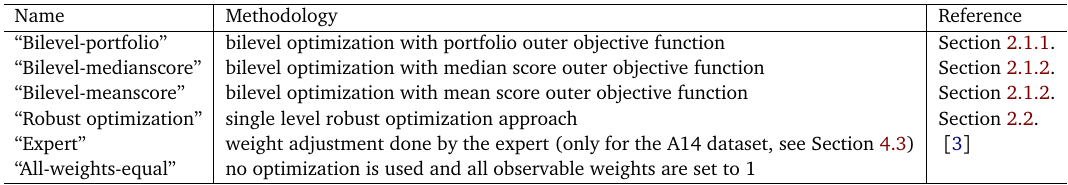
Table 2: Optimization methods used in this